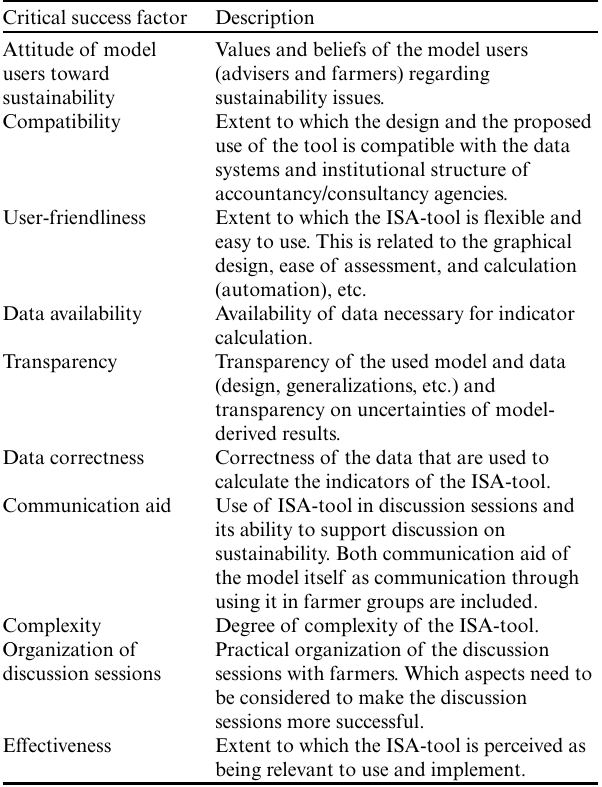
Table 2 . Critical success factors for implementation of integrated sustainability assessment tools, according to De Mey et al.